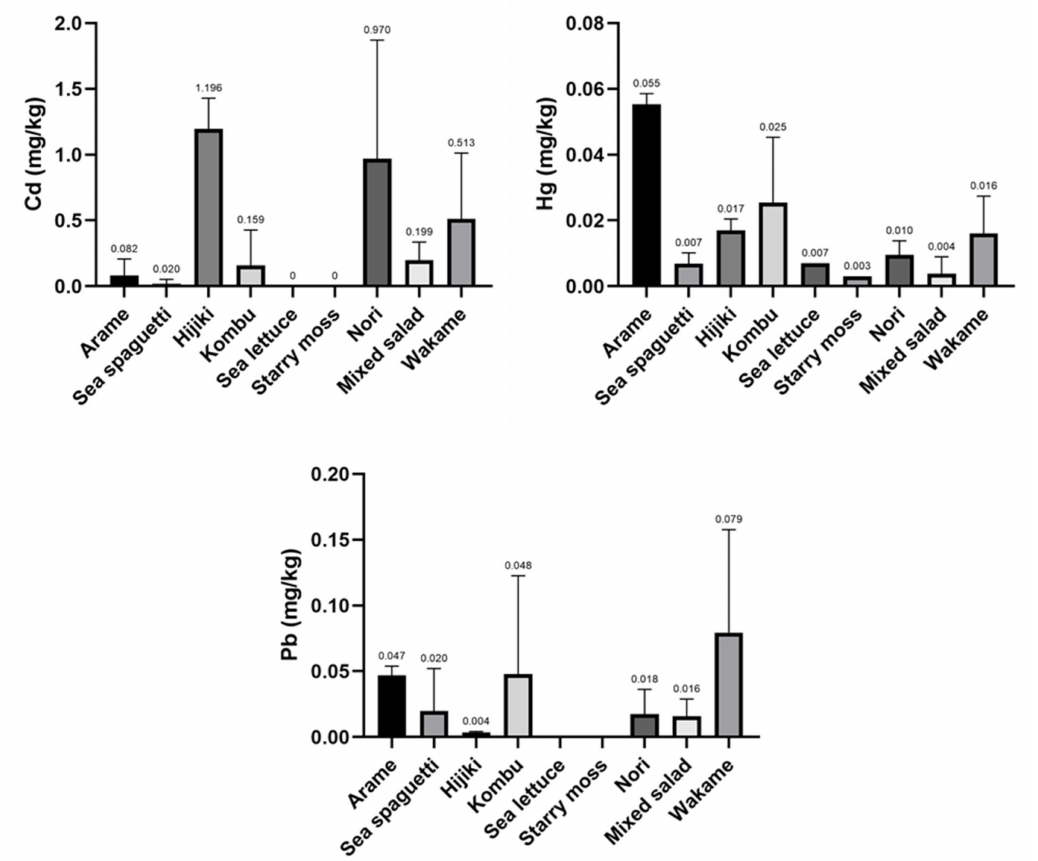
Figure 2. Comparison of the toxic metal content (Cd, Pb, Hg) in the different species of analyzed